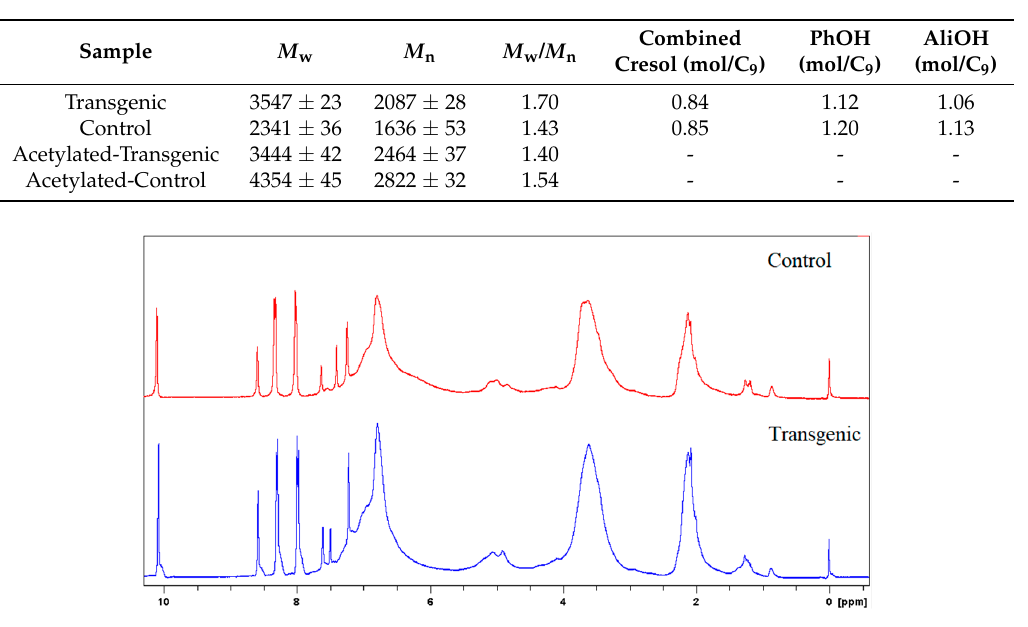
Figure 3. 1 H NMR spectra of LCs.